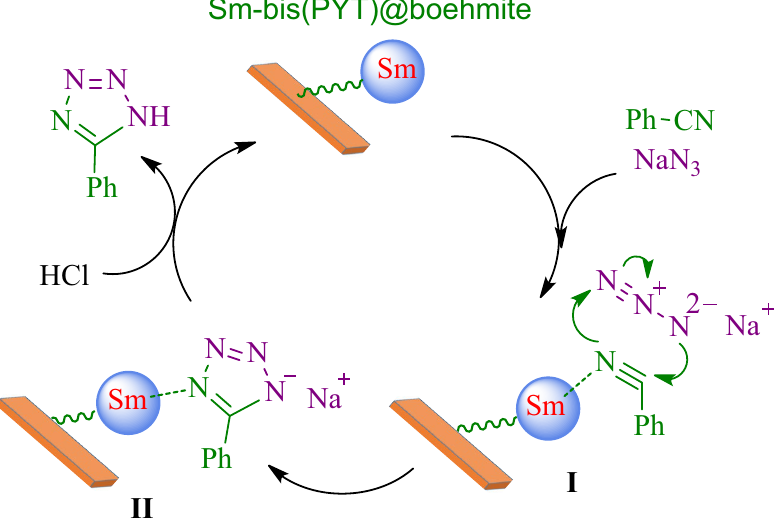
Figure 13. An expected mechanism for synthesizing 5-substituted 1H-tetrazoles in the presence of Sm-bis(PYT)@boehmite.